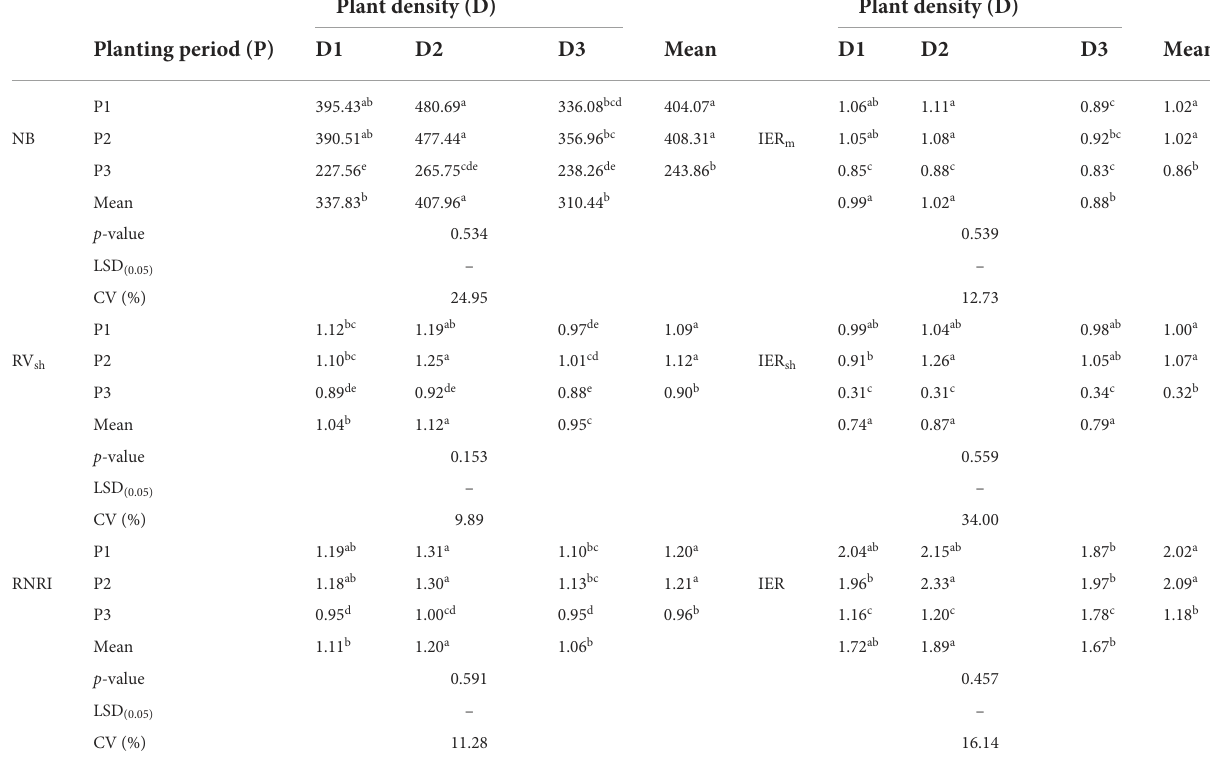
TABLE 4 Effects on sunn hemp management on net benefits (NB), replacement value of sun hemp (RV sh ), relative net return index (RNRI), maize income equivalent ratio (IER m ), sunn hemp income equivalent ratio (IER sh ), and income equivalent ratio (IER) under in-field rainwater harvesting technique in the central semiarid area of the Free State Province, South